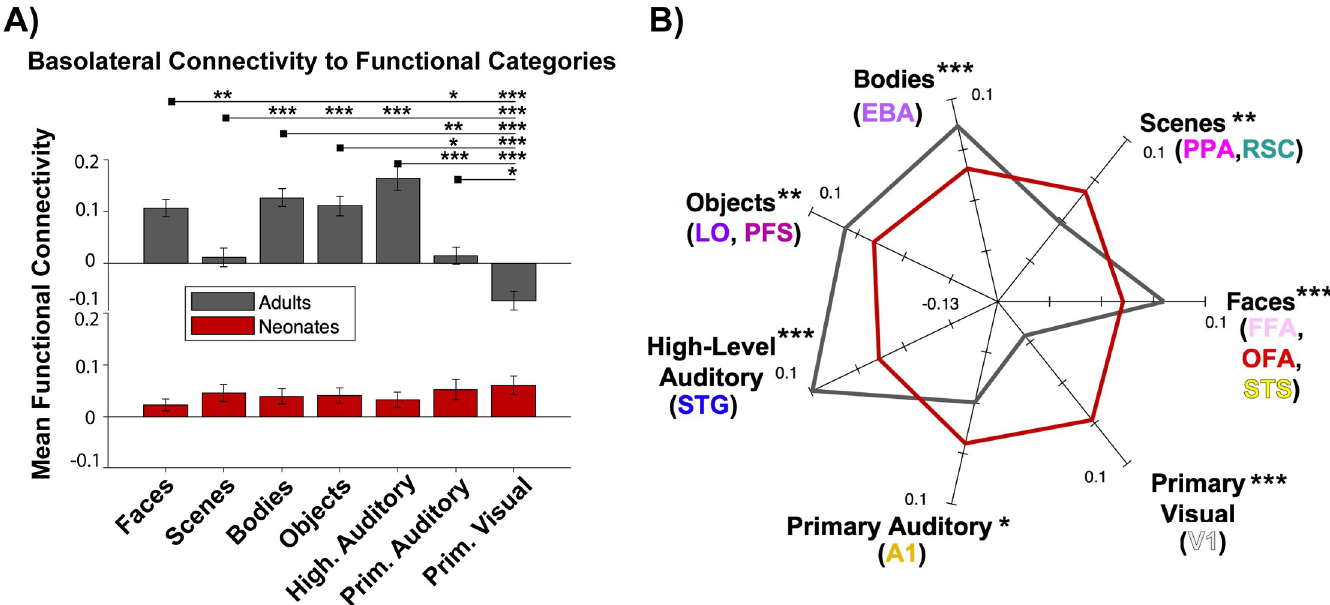
Fig 3. Functional connectivity to functional categories. (A) Bar plot of mean functional connectivity to each of the 7 functional categories, with adults in gray and neonates in red. Error bars are standard error of the mean. � p < 0.05, �� p < 0.01, ��� p < 0.001 (C) FC fingerprint plot depicting the pattern of connectivity of both samples. Axes are mean centered FC values for each sample. Parentheses show which of the 11 parcels were included in each category. Asterisks denote significance between groups for each category.